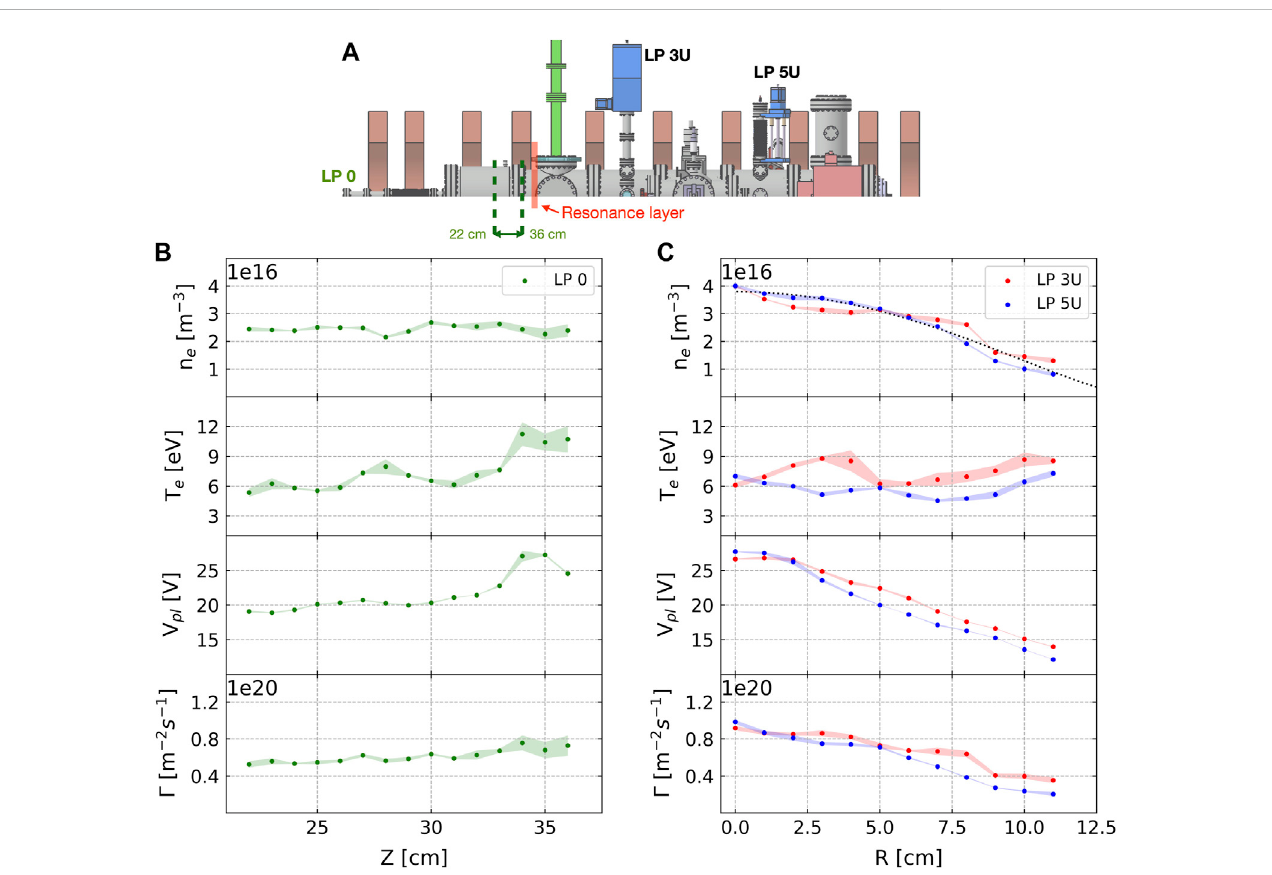
FIGURE 5 Layout of the linear shifts (A) . The fi rst system was installed on port 0 to measure the axial pro fi le of the plasma. The second and the third systems were installed on ports3U and 5U, to obtain theradial pro fi les ofthe plasma. Three cylindrical single SST LPs were installed on theshifts, with themajor axis normal to the machine axis. The length and diameter of the tips were 15 mm and 1.5 mm. Electron density, n e , temperature, T e , plasma potential, V pl , and ion fl ux, Γ , along the axial, Z (B) , and radial, R (C) , coordinate, measured for an Ar plasma, with SM source power of 1200 W, a pressure of 8.0 × 10 – 3 Pa and the axial magnetic con fi guration with I coils = 600 (A) . Each scatter point is the average of the plasma parameter values obtained from three repeated measurements, and the shadowed region represents the associated standard deviation. The dotted black line in the n e plot of fi gure (C) is the parabolic fi t of n e ,5 U